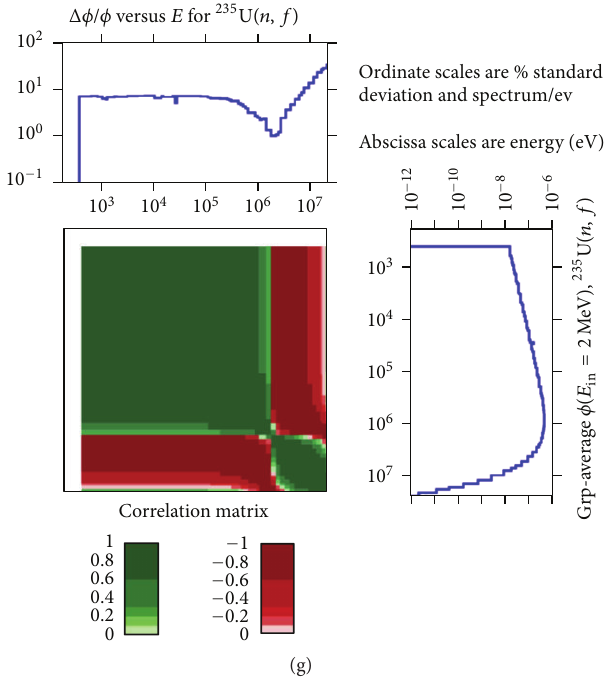
F 4: Covariance plot